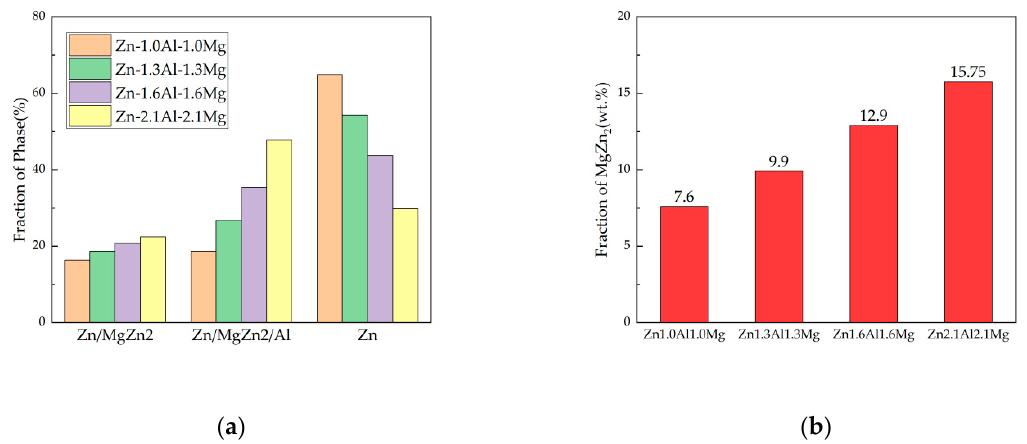
Figure 8. The results of PADAT-simulated non-equilibrium solidification; ( a ) phase fraction, ( b ) MgZn 2 fraction.